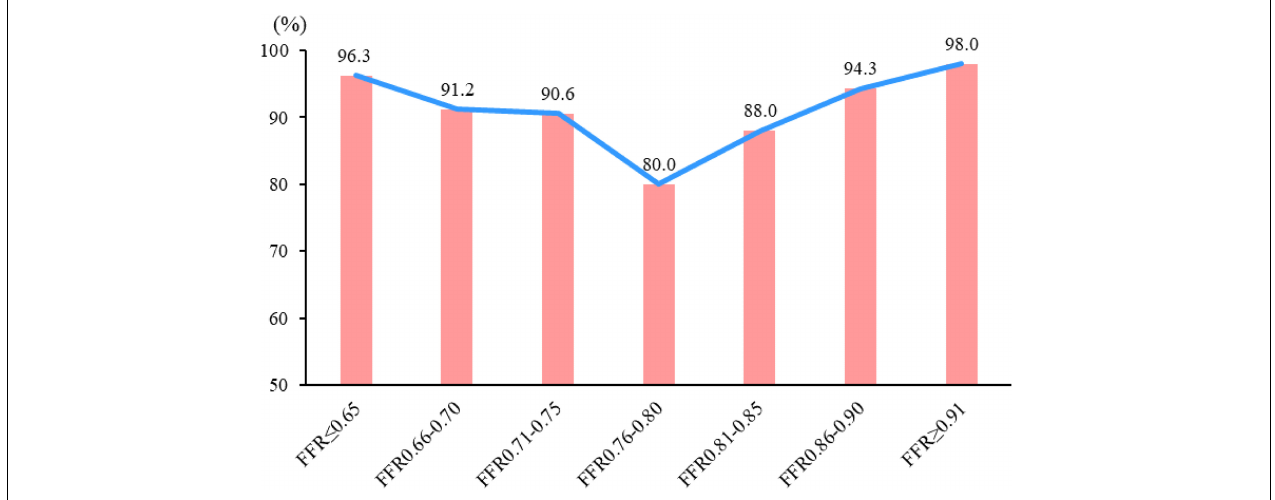
FIGURE 5 | Diagnostic accuracy of CT-FFR in different FFR categories. The diagnostic accuracy of CT-FFR among the different FFR groups in correctly identifying the hemodynamically ischemic lesions is shown. The diagnostic accuracy of lesions in “gray zone” lesions (FFR = 0.75–0.80) was the lowest, and the farther from the gray zone, the higher the accuracy. TABLE 4 | Coronary atherosclerosis burden of lesions in “gray zone.”